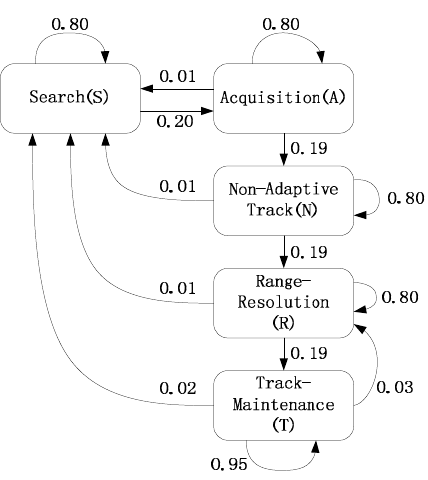
Figure 3. Operating mode transition of the MFR.